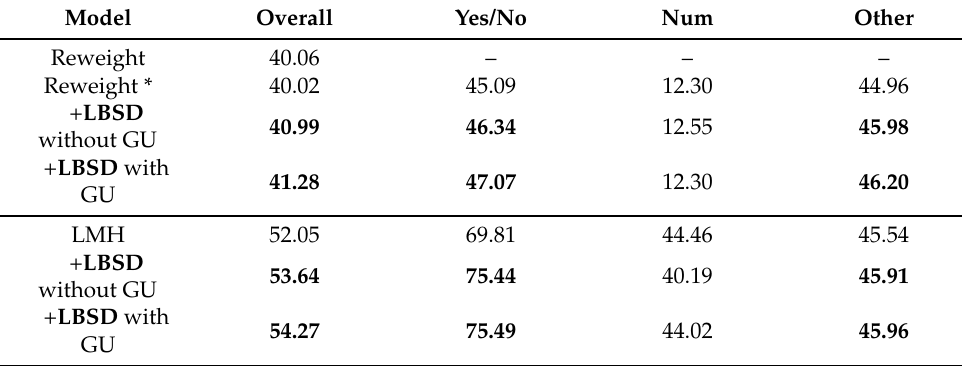
Table 4. VQA-CP v2: Ablation experiments of the generalization uncertainty method on the VQA-CP v2 dataset. * indicates the results from our reimplementation using officially released